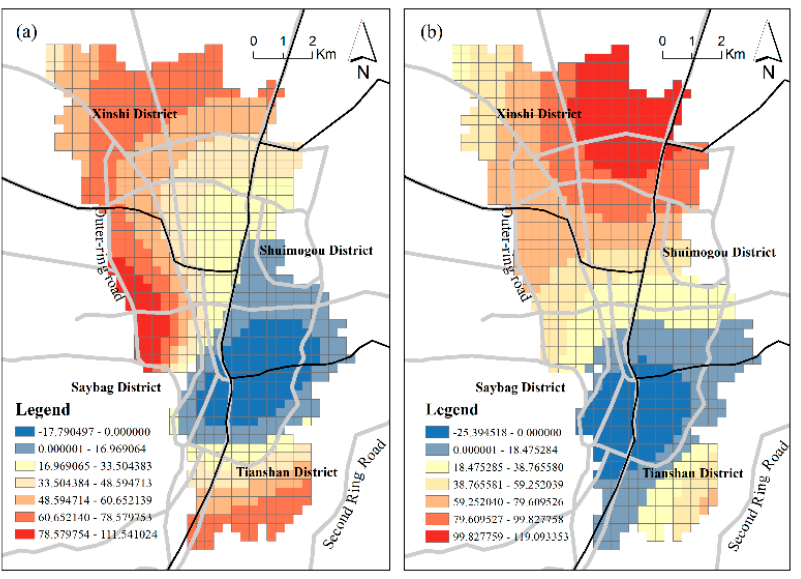
Figure 4. The coefficient of MU; ( a ) Model 1; ( b ) Model 2.